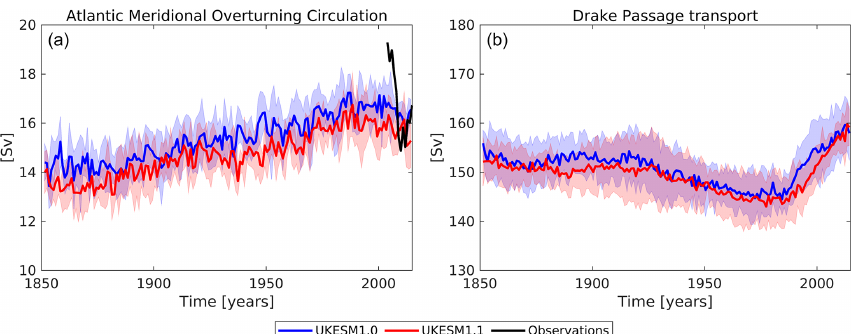
Figure 13. Atlantic meridional overturning circulation (AMOC; a ) and Drake Passage transport (b) for the UKESM1 (blue) and UKESM1.1 (red) ensembles. Solid lines denote the ensemble mean, with shaded areas marking ± 1 standard deviation. Estimated AMOC transport derived from the RAPID array (Smeed et al., 2018) is shown in black for the period of available observations.